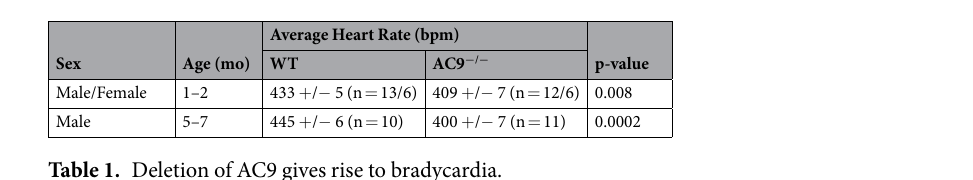
Reduced heart rate in the absence of AC9. Functional analysis of WT and AC9 − / − mice revealed a sig- nificant reduction of heart rate under isoflurane in both male and female mice for the two age groups examined (Table 1). Body weight is unaltered in male (21.1 + / − 0.2 versus 21.6 + / − 0.3 g, 6 months) and female mice (15.3 + / − 0.2 versus 15.6 + / − 0.2 g, 4 months). No structural abnormalities were noted and myocardial performance index (0.9 + / − 0.1 versus 0.9 + / − 0.1), ejection fraction (53 + / − 3 versus 51 + / − 4) and percent fractional shortening (27 + / − 2 versus 26 + / − 3) were all unchanged, as assessed by M mode imaging of mice 3–7 months (Supplemental Table 1). Alterations in heart rate suggest a role for AC9 in sinoatrial node (SAN). Yotiao-AC9 complex is detected throughout the heart, including the left ventricle, atria, and the SAN, as measured by AC9 activity associated with Yotiao immunoprecipitation (Fig. 2E). As shown for total heart, deletion of AC9 abolishes Yotiao-associated activity in SAN (Fig. 2F), consistent with a role for AC9 in heart rate control. Correct dissection of SAN is confirmed by the presence of connexin 45 but not connexin 43 (Supplemental Fig. S1) 18 . Global PKA phosphorylation is unaltered but Hsp20 phosphorylation is decreased in AC9 − / − . In order to determine if AC9 deletion alters cAMP signaling, we used intraperitoneal injection of saline or isoproterenol in WT and AC9 − / − mice to evaluate changes in phosphorylation of PKA targets. Global changes in PKA phosphorylation at baseline or after isoproterenol injection are not detected (Fig. 3A), suggest- ing that AC9 does not significantly alter sympathetic responses. However, we detect a large decrease in the basal phosphorylation state of Hsp20 in the absence of beta-adrenergic stimulation (Fig. 3B). Hsp20 is a known PKA target 19, 20 and inhibition of PKA activity by H89 blocks isoproterenol-stimulated phosphorylation of Hsp20 in rat